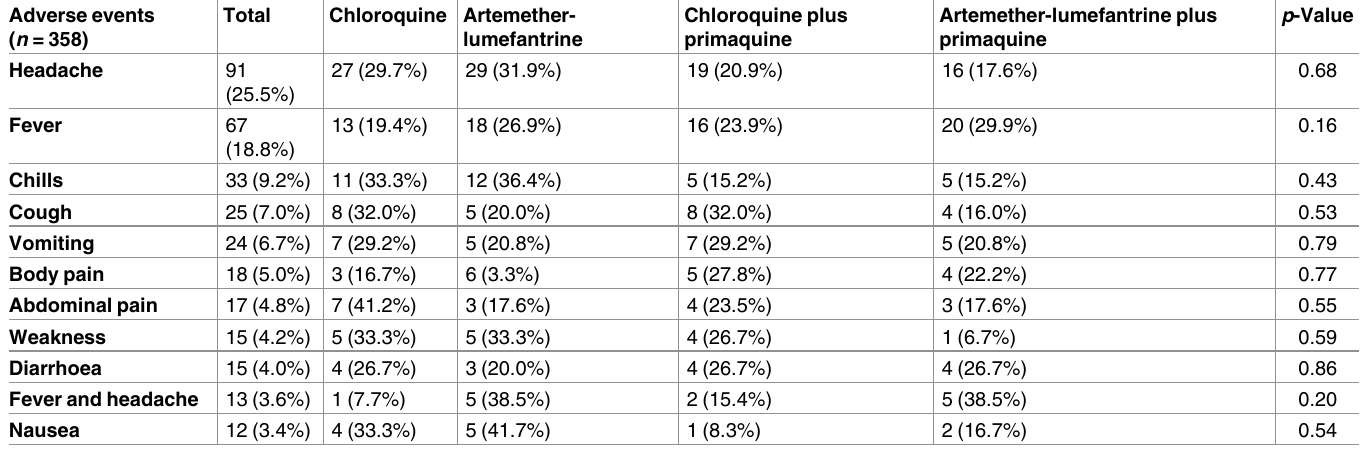
Table 5. Adverseevents by treatment